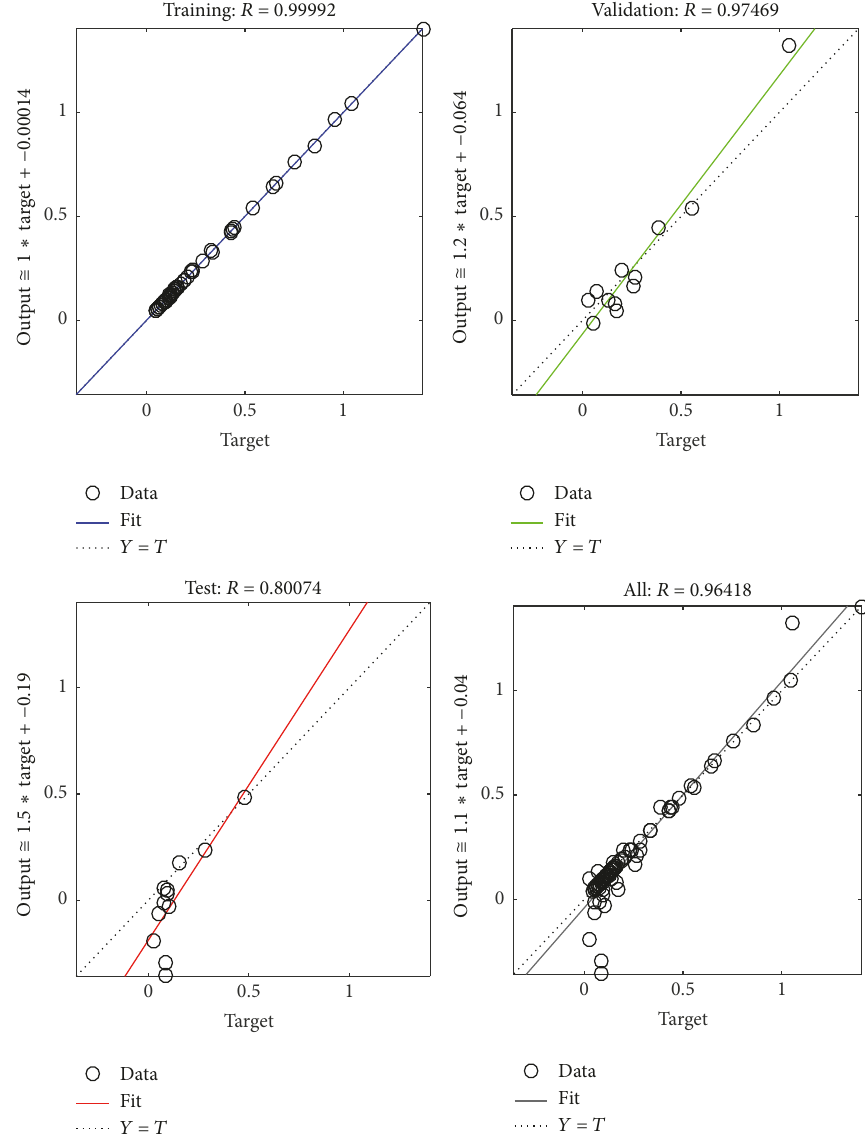
Figure 22: Regression plot across all